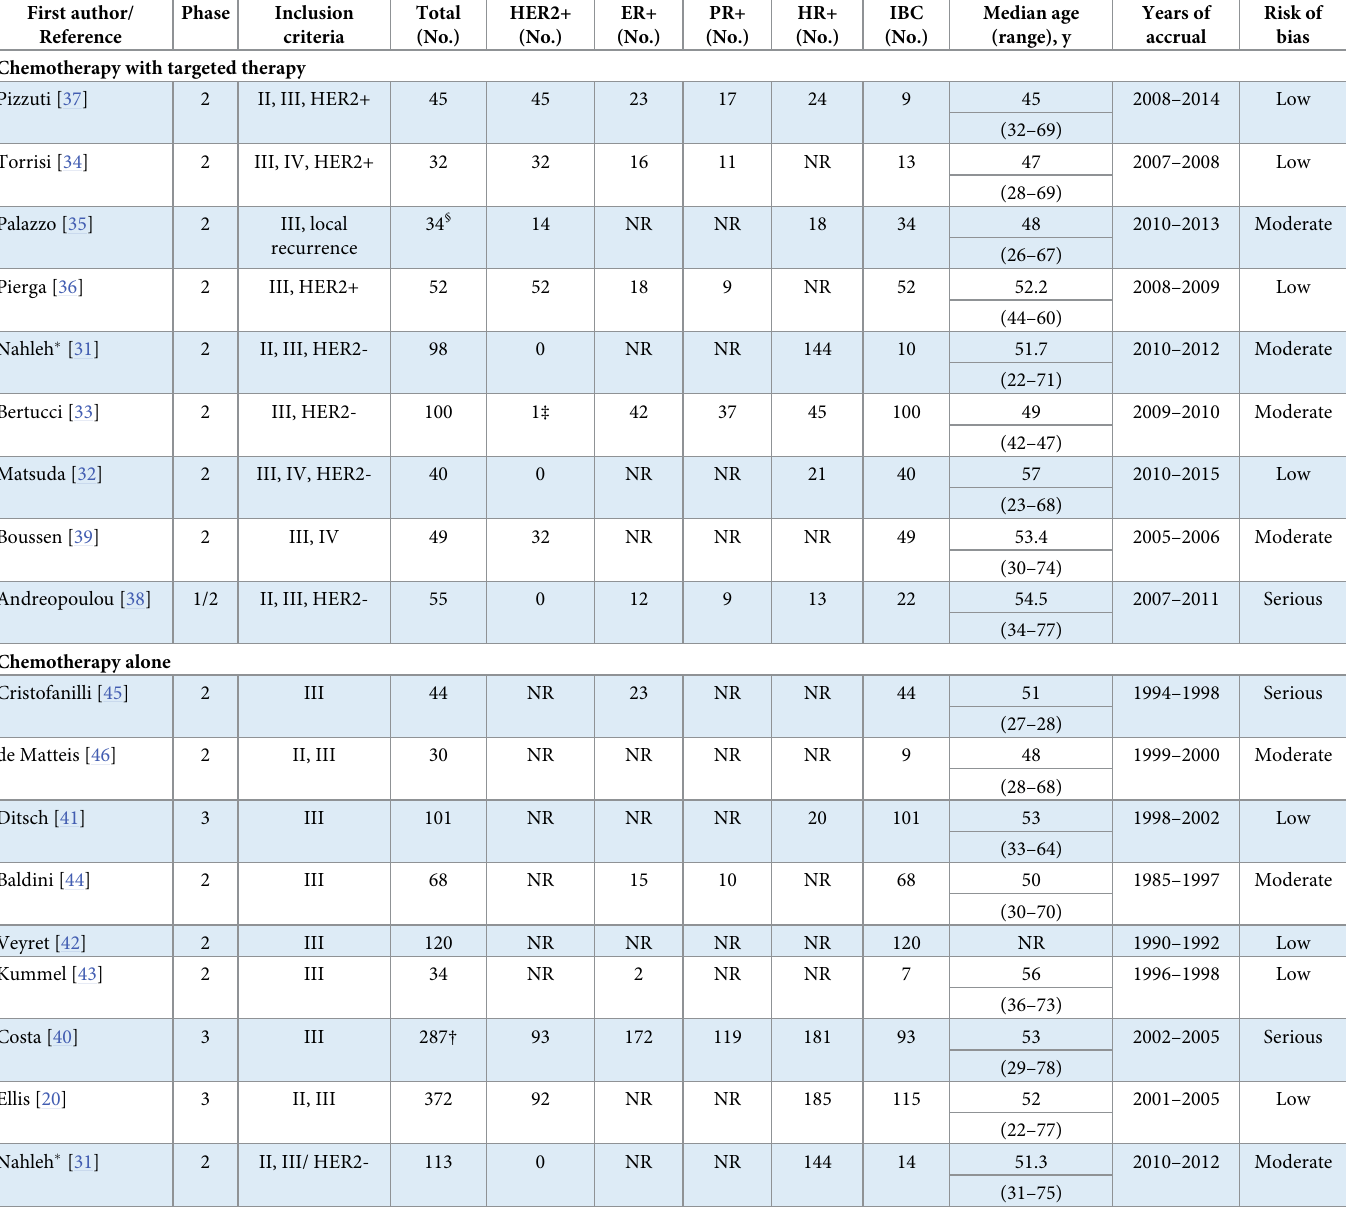
Table 1. Characteristics of the included studies and baseline characteristics of the patients in those